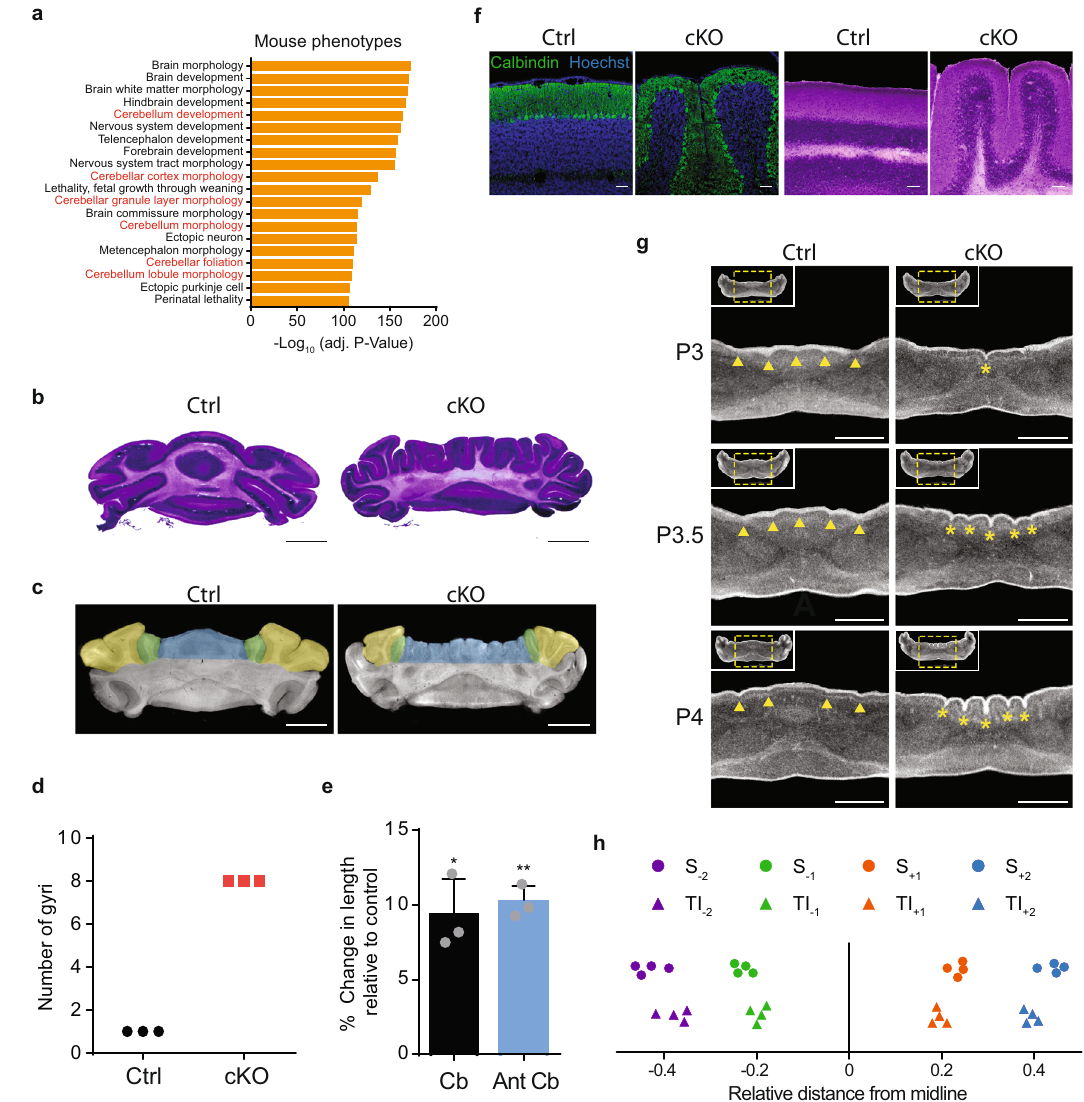
Fig. 4 Conditional knockout of CHD7 results in stereotyped cerebellar microgyria. a GREAT analysis showing enriched mouse phenotypes associated with CHD7-regulated genes. Cerebellar phenotypes shown in red text. b Hematoxylin and eosin staining of Ctrl (left) and CHD7 cKO (right) p56 sections of mouse cerebellum. Scale bar: 2 mm. c Zeiss Xradia Versa 520 XRM was used to perform a nano-computerized tomography (nano CT) scan of Ctrl (left) and cKO (right) p56 mouse cerebella. The cerebellar vermis is highlighted blue and corresponding hemisphere regions highlighted green and yellow. Scale bar: 2 mm. d Graph showing number of gyri in the cerebellar vermis of the anterior basal lobe of Ctrl and cKO mice ( n = 3 for each condition). e Bar graphs showing % change in total cerebellar (Cb) and anterior lobules (Ant Cb) lengths upon CHD7 cKO ( n = 3 for each condition). Length is shown as mean ± s.e.m for each measurement. p = 0.0188 (Cb), p = 0.0024 (Ant Cb) Paired two-sided t -test. f IHC (left) and H&E (right) of Ctrl and cKO p56 mouse cerebellar sections. Experiment was repeated three times for each condition. Scale bars: 100 µ m. g Nano CT scans were taken of P3, P3.5, and P4 mice cerebella. Digital 2D sections were taken through anterior basal lobe lobules. Insets show entire cerebellar section. Yellow dashed squares de fi ne region of focus. Yellow arrowheads on P4 Ctrl section mark transient vermal indentations. Yellow asterisks on P4 cKO section mark aberrant sulci. Scale bars: 500 µ m. h Dot plot showing relative distance of transient invaginations (TI) in P4 CHD7 ctrl mice ( n = 4) and sulci (S) formation in P4 CHD7 cKO mice ( n =